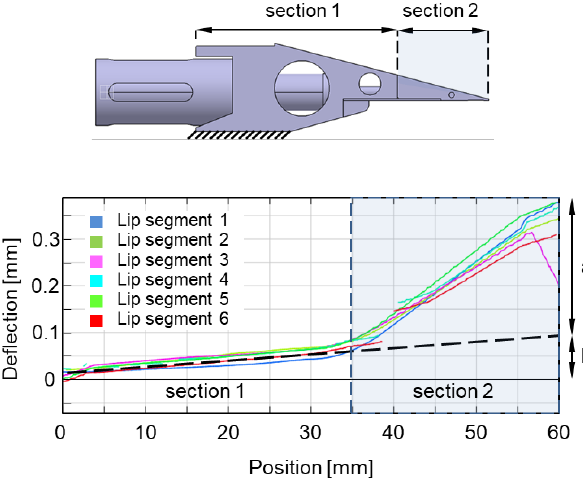
Figure 13. ( Top ) Schematic view of a lip segment; ( Bottom ) Displacement along the lip segment measured with a digital image correlation (DIC)-system at a plenum pressure of 0.6 bar.